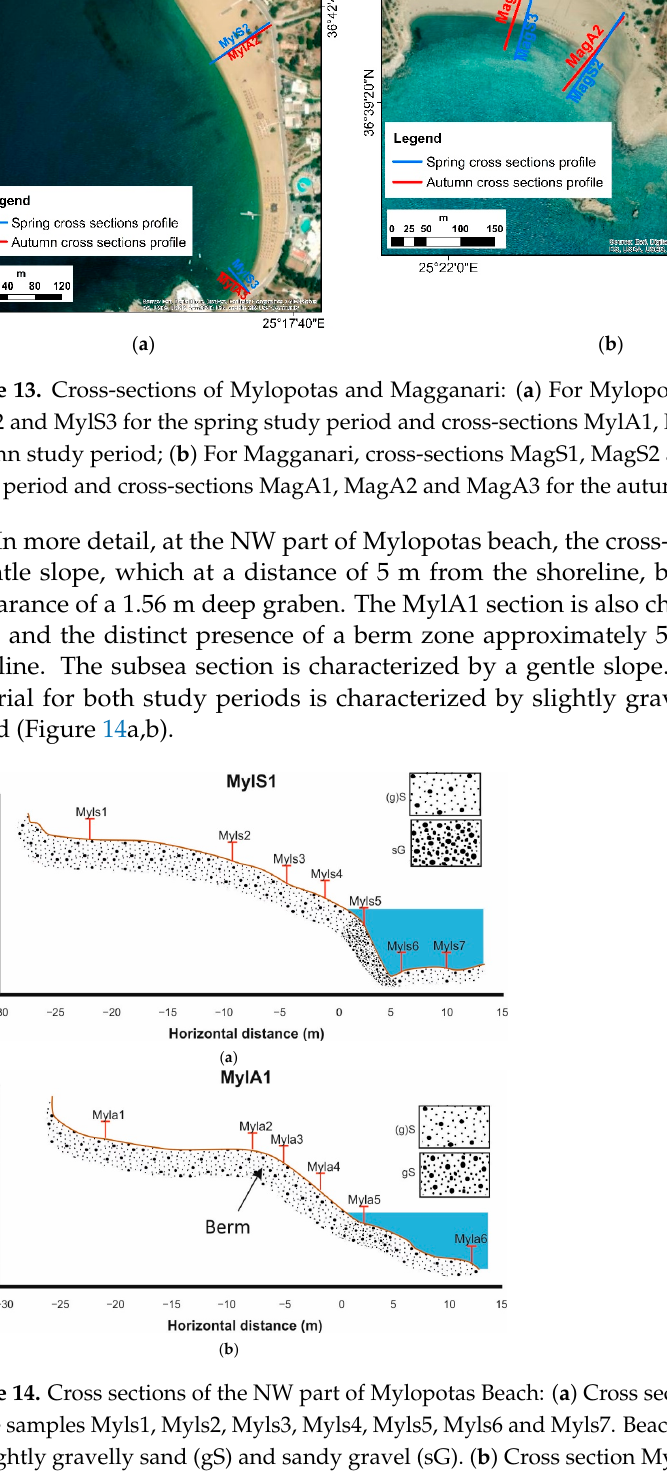
Figure 14. Cross sections of the NW part of Mylopotas Beach: ( a ) Cross section MylS1 is represented by the samples Myls1, Myls2, Myls3, Myls4, Myls5, Myls6 and Myls7. Beach material is characterized by slightly gravelly sand (gS) and sandy gravel (sG). ( b ) Cross section MylA1 is represented by the samples Myla1, Myla2, Myla3, Myla4, Myla5 and Myla6. Beach material is characterized by slightly gravelly (g)S sand and gravely sand (gS). The arrow points to the berm zone along the cross- section. In the central part of the beach, cross-sections MylS2 and MylA2 are characterized by stable topography on a seasonal scale. The first berm zone at a distance of 6.5 m from the coastline in MylS2 has been preserved in MylA2 and has been shifted to a distance of 7.5 m from the coastline. In the subsea section, the graben and subsequent ridge have been normalized. The beach material in MylS2 is characterized by alternations between slightly gravelly sand and gravelly sand, which turns into sandy gravel and gravelly sand under- water, mostly moderately sorted. At section MylA2 a continuous occurrence of slightly gravelly sand is noted, which grades into gravelly sand towards the shoreline, the major- ity of the samples are moderately sorted (Figure S2a,b). In the southern part of the beach, the topography, as presented by cross-sections MylS3 και MylA3, does not differ for the two seasonal profiles. The material of the beach changes from sandy gravel to sand with the predominance of very platykurtic kurtosis and very fine skewness. Cross-section MylA3 is characterized by slightly gravelly sand, coarse skewed and mainly moderately sorted (Figure S3a,b). Cross-sections MagS1 and MagA1 represent the eastern bay of Magganari beach, where the berm zone is observed. Toward the coastline, the slope becomes steeper, with a graben occurring approximately 6 m from the coastline for both profiles. The beach ma- terial of the eastern bay is characterized by the successive appearance of slightly gravelly